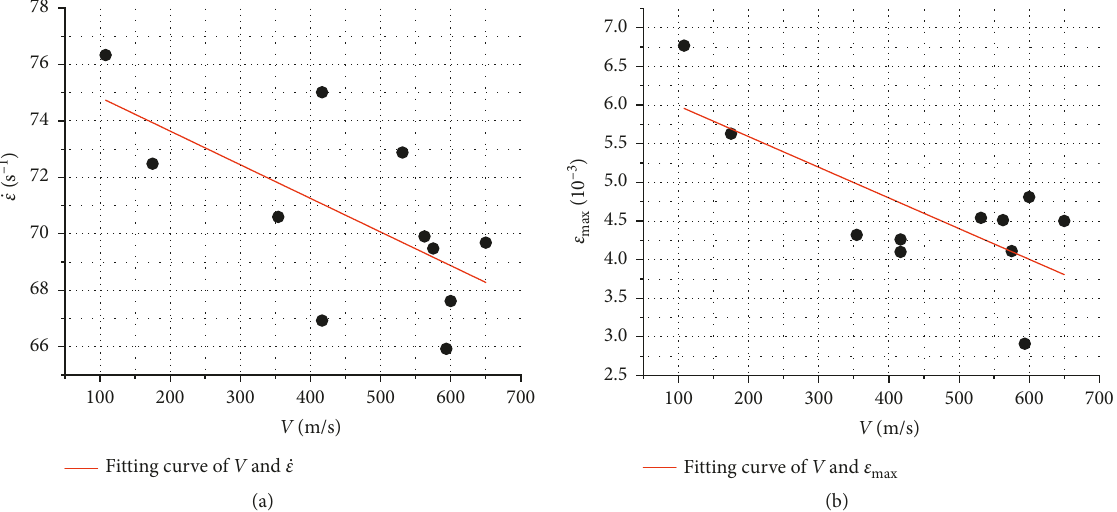
Fitting curve of V and ε Figure 17: Curves of strain parameters with crack propagation velocity V and associated results after linear fitting. (a) _ ε as a function of V ; as a function of V (b) ε max